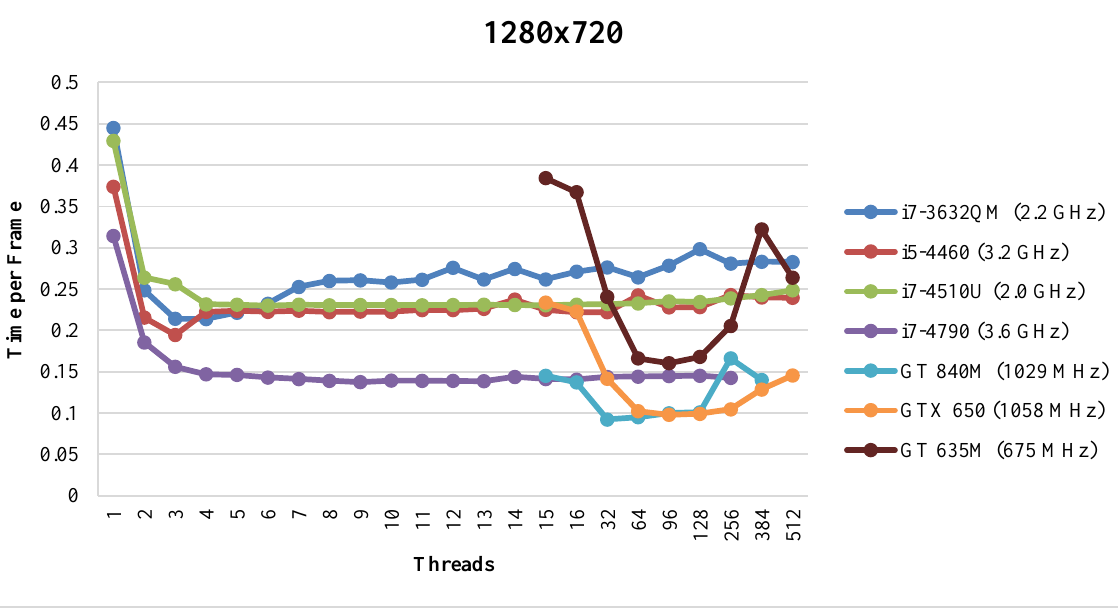
Figure 10. Compare the runtime of different threads for different CPU and GPU to generate an image in 720p